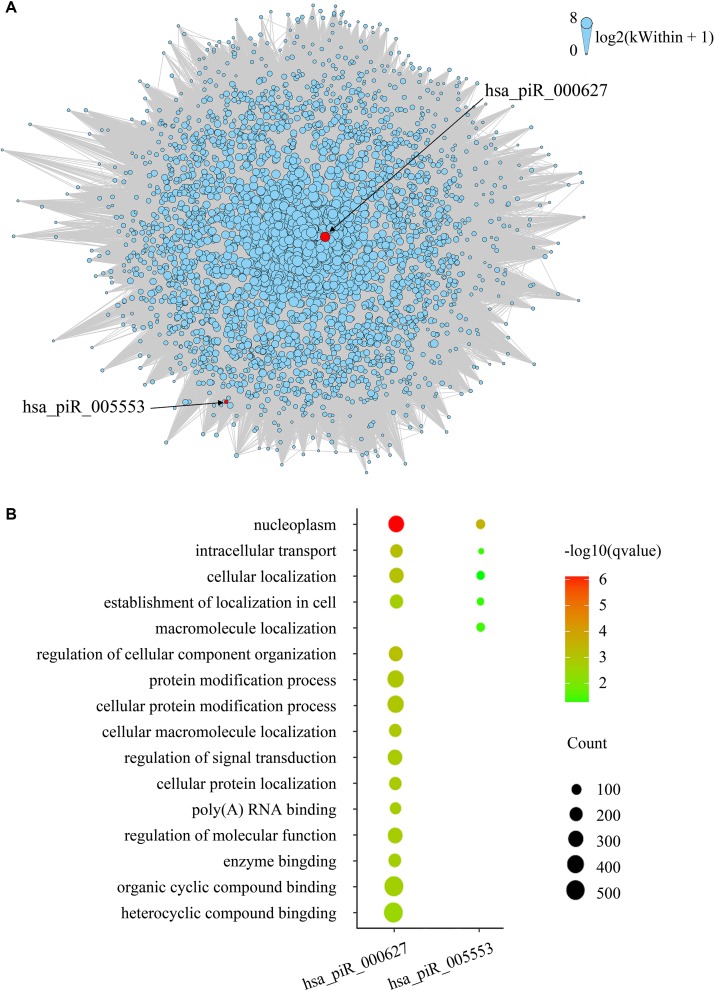
(A) Network of the module brown. piRNAs in the modules are represented by the red nodes and labeled. Edges mean the interaction between genes. Intramodule connectivity (k
Within) of each node is represented by the size of node, which was transformed to log2(k
Within + 1). (B) Top gene ontology terms for the targeted genes of hsa_pir_000627 and hsa_pir_005553, respectively. The gene count of each module was represented by the size of spot and the –log10(q-value) was represented by the color of the spot.